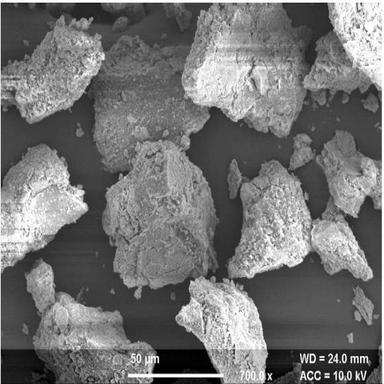
SEM image of Ch-PANI-NiO composite.